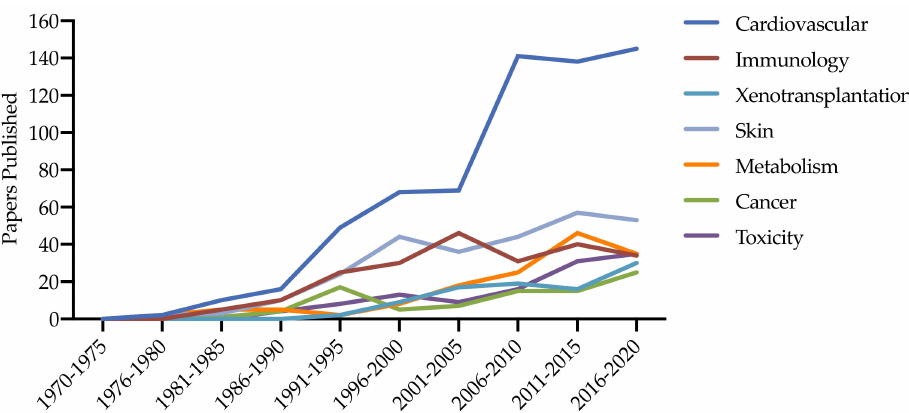
Figure 4. The use of minipig biomedical models over time based on articles indexed by PubMed from 1970 to 2020